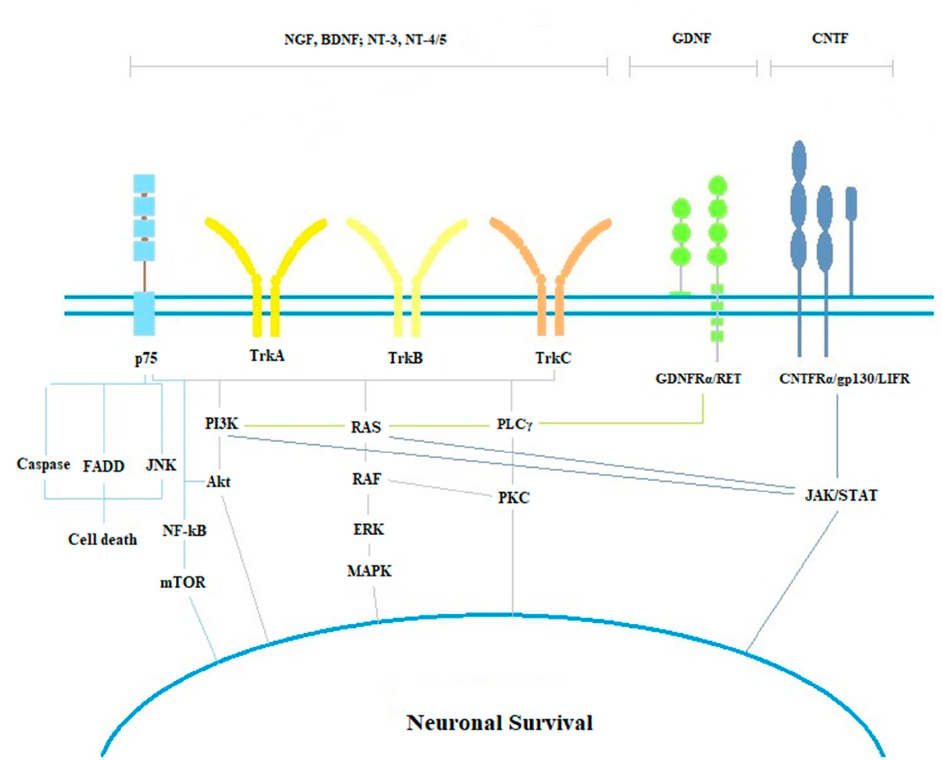
Figure 2. Neurotrophic factors (NTFs) multiple signaling pathways. The tropomyosin receptor kinases (TrkA, TrkB, and TrkC) promote neuronal survival through the activation of the Ras / ERK / mitogen-activated protein kinase (MAPK) pathway, the phosphatidylinositol-3-kinase (PI3K) / Akt pathway, and the phospholipase C (PLC)- γ pathway. The low-affinity neurotrophin receptor p75 NTR induces cell death through the activation of caspases, c-JUN N-terminal kinase (JNK), and fas-associated protein with death domain (FADD) pathways, but it is able to induce cell survival through the nuclear factor kappa-light-chain-enhancer of activated B cells (NF-kB) / mTOR pathway and AKT in dependence of Trk receptors concurrent expression. The GDNF α receptor and tyrosine kinase RET receptor activate PLC- γ , Ras / ERK / MAPK and PI3K pathways. The CNTFR α receptor and the two subunits gp130 and leukemia inhibitory factor (LIFR) receptor activate the JAK / STAT, Ras / ERK / MAPK, and PI3K